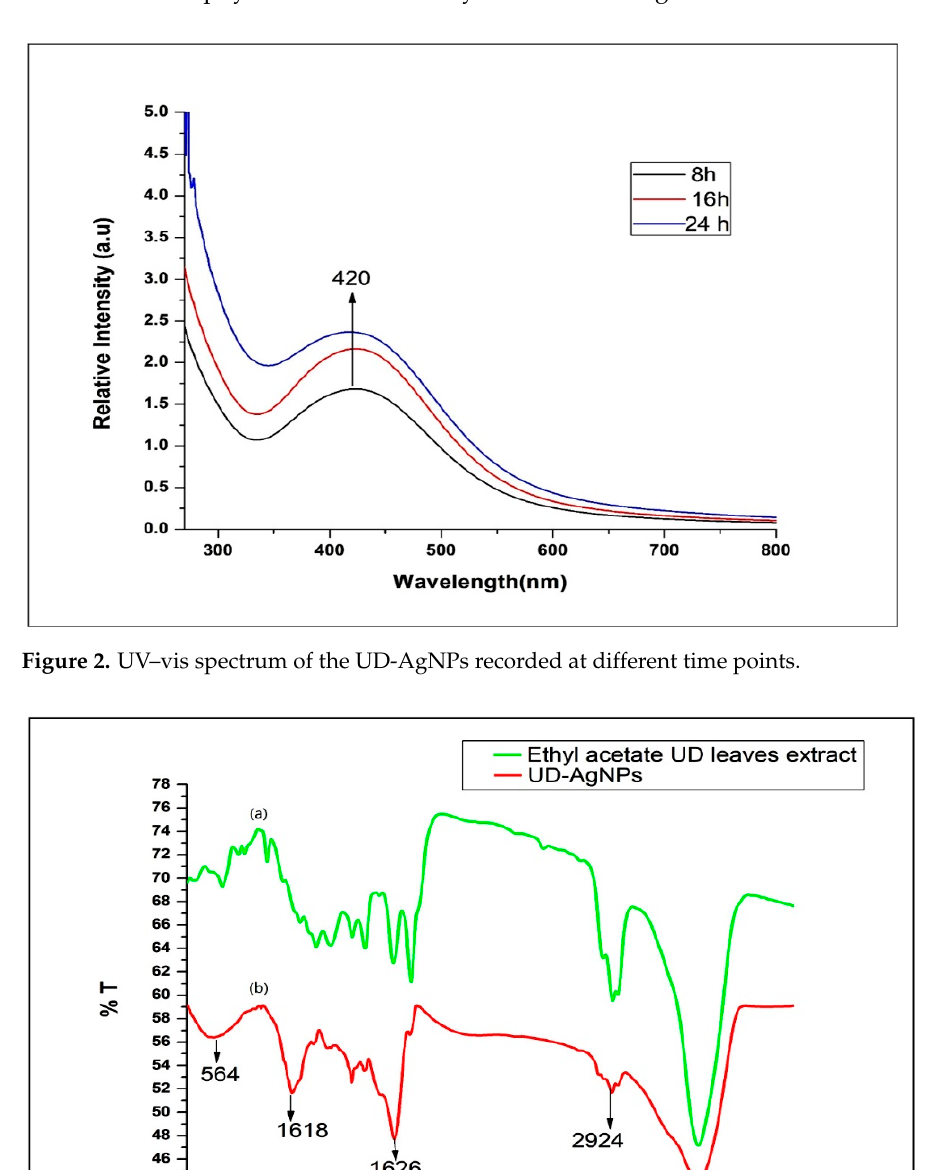
Figure 2. UV–vis spectrum of the UD-AgNPs recorded at different time points.